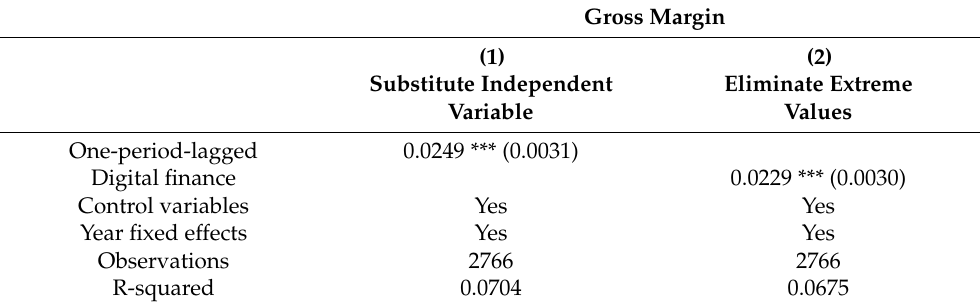
Table 4. Robustness tests by substituting independent variable and eliminating extreme values.